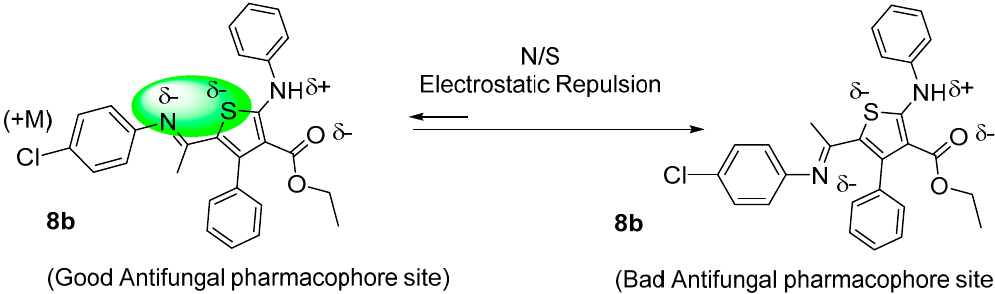
Figure 9. Impact of electronic positive mesomeric effect on geometry and antifungal activity of molecule 8b .